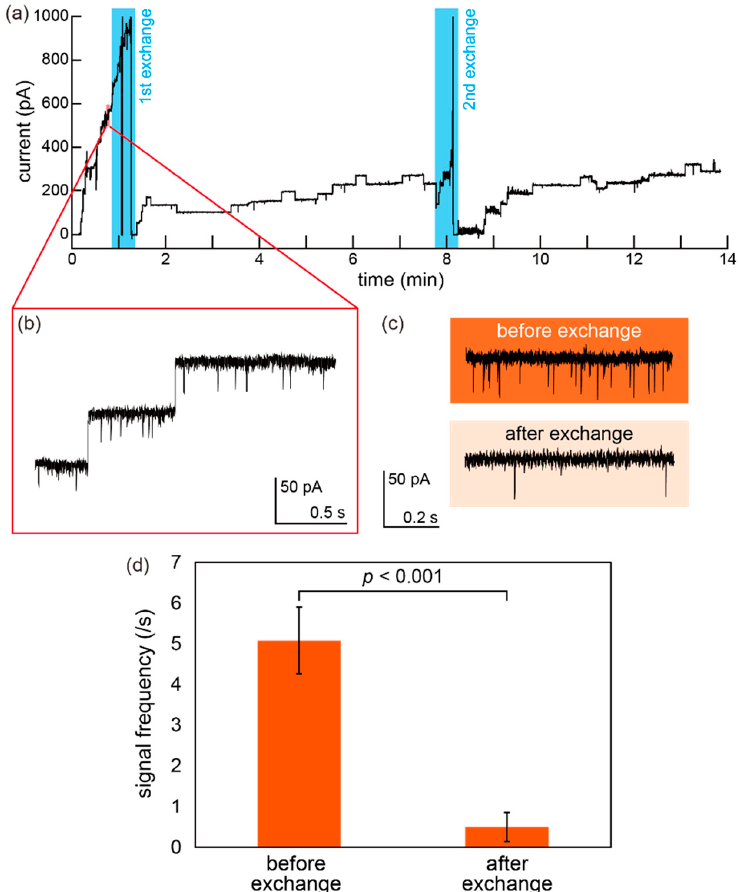
Figure 9. ( a ) Time-course monitoring of ionic current through the nanopore reconstituted in the mini-cup device. The solution exchange was conducted while maintaining the lipid bilayer. The light blue areas indicate the 1st and 2nd solution exchanges. Applied voltage: 100 mV. ( b ) Enlarged view of the current trace of serial nanopore formations in a lipid bilayer. ( c ) Typical blocking signals by ssDNA before and after the first exchange. ( d ) Frequencies of the blocking signals by ssDNA. In